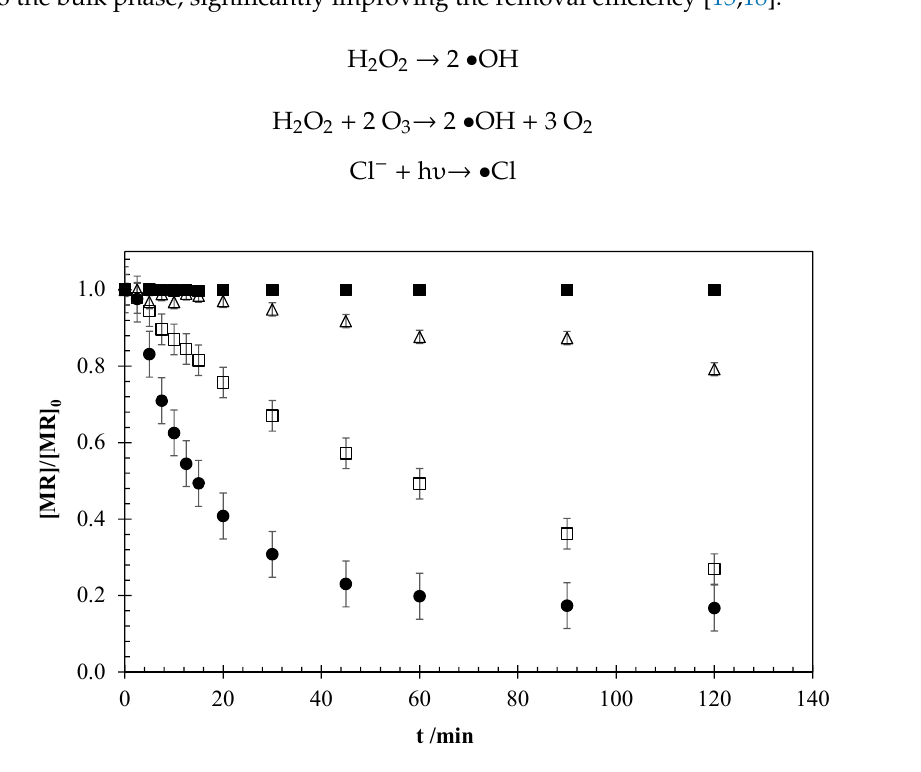
Figure 4. XRD pattern of the generated solid. Maxima noted with an asterisk belong to NaCl.